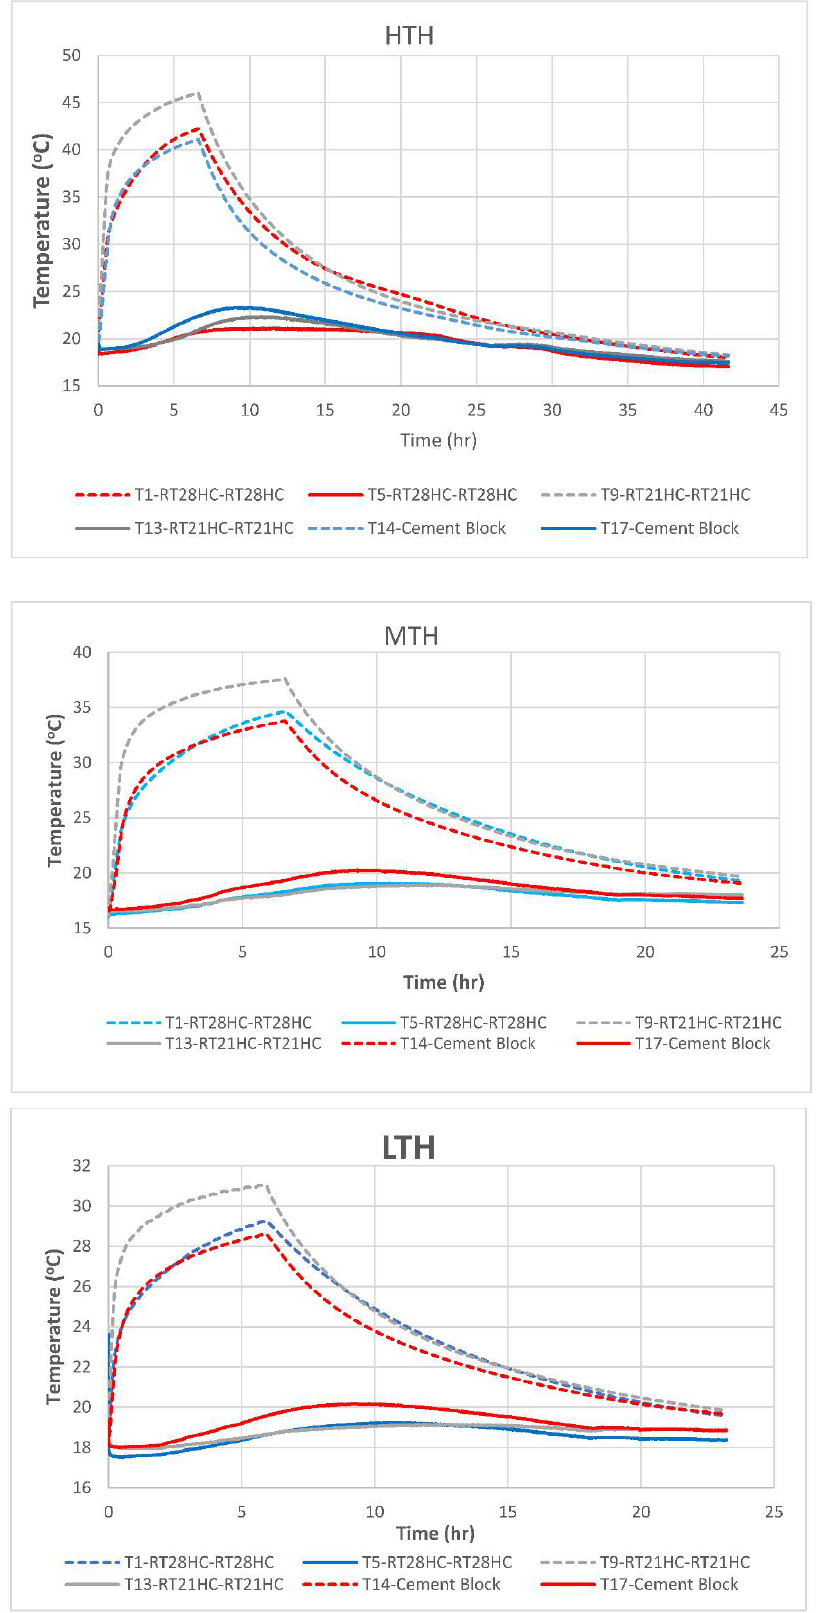
Figure 12. Temperature distribution of baseline case of cement block and PCM RT28HC–RT28HC and RT21HC–RT21HC.